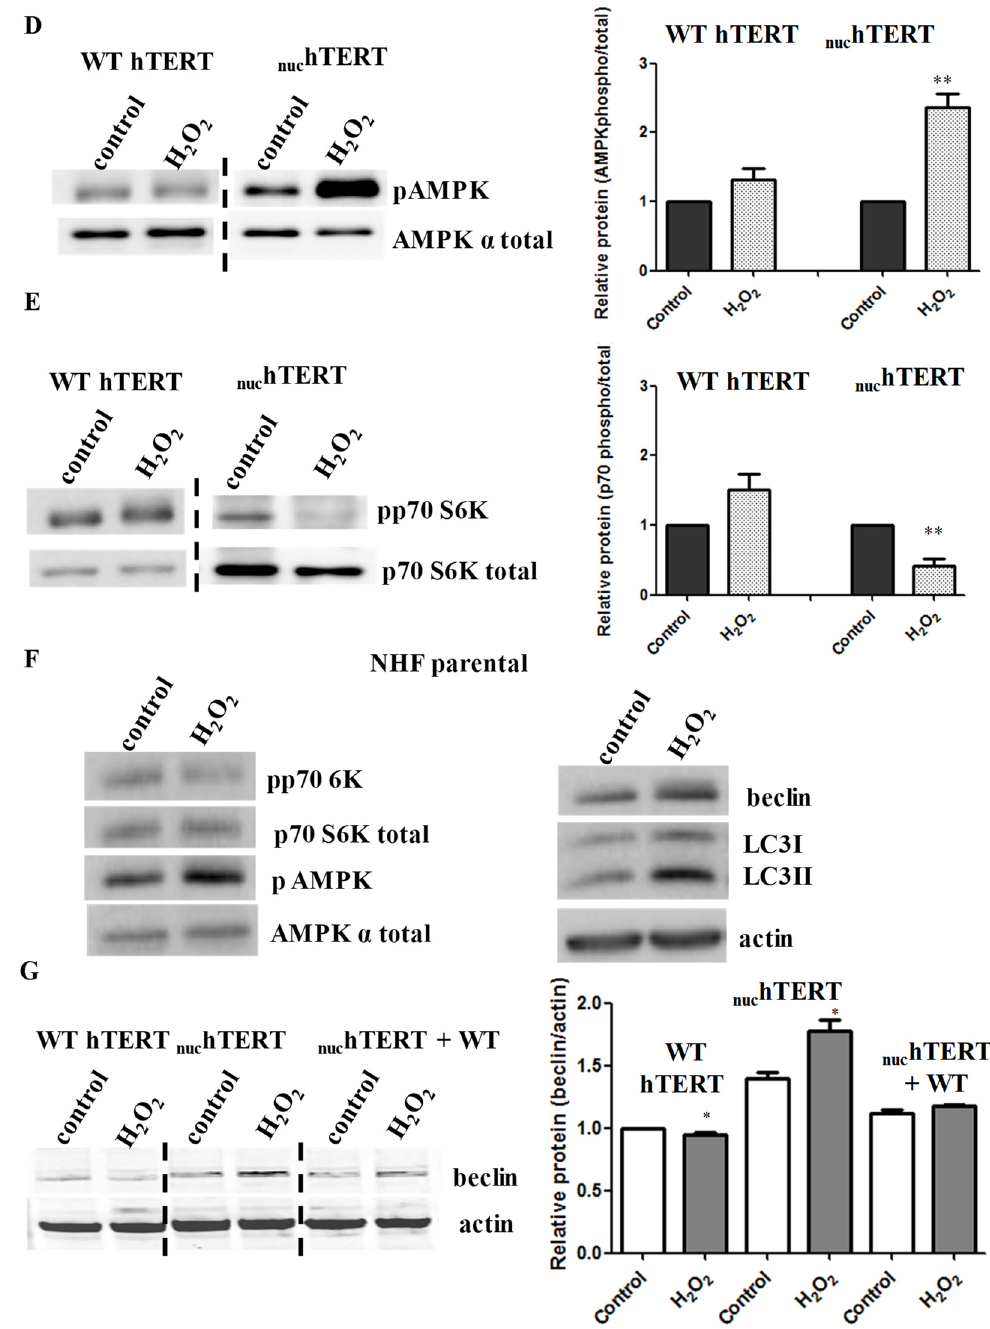
Figure 2. Cont Figure 2. Autophagy is upregulated upon oxidative stress but only when hTERT does not enter mitochondria. ( A ) WT hTERT and nuc hTERT were submitted to 60 minutes of 200 µM H 2 O 2 treatment and allowed to recover in conditioned medium for 24 hours. The cells were then harvested and assayed with Yopro-1 and propidium iodide to monitor apoptosis (YoPro-1) and cell death (propidium iodide) using flow cytometry. Graphs depict the mean of at least three biological experiments ± SEM. Student t-test was performed by comparing each corresponding cell death marker to its representative control. p value < 0.05*. ( B ) WT hTERT and nuc hTERT cells were subjected to 200 µM of H 2 O 2 for 60 minutes (0 hour), and allowed to recover at two, six, and 24 hours. After the removal of H 2 O 2 the cells were cultured in conditioned medium (medium in which cells had grown overnight containing cells released-growth factors) for the two, six, and 24 hours recovery time points. Levels of beclin were normalized to actin. Graph represents the average of eight independent experiments ± SEM. Student t-test was performed by comparing each treated sample — 60 minutes H 2 O 2 and the recovery time points to its respective control (untreated cells). Statistical significance